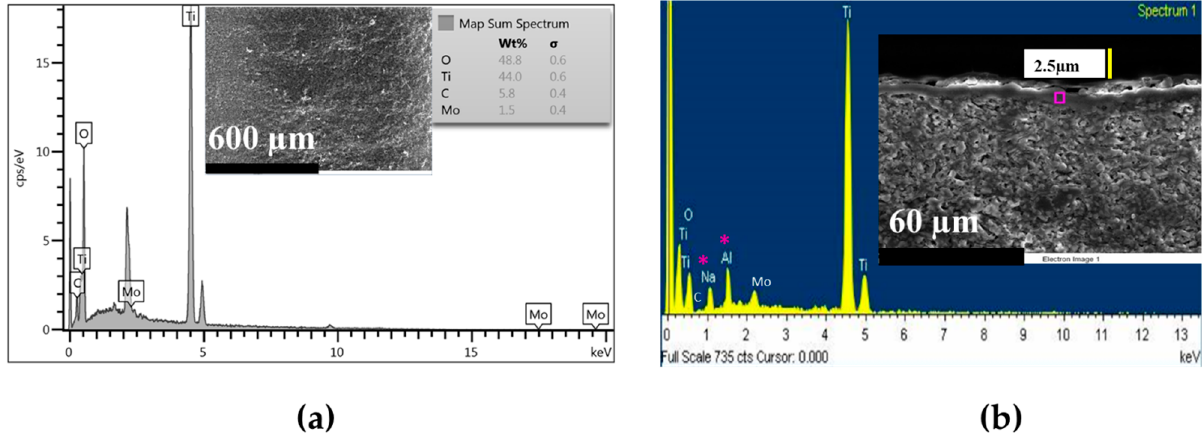
Figure 9. ( a ) SEM-EDS and ( b ) cross-sectional SEM-EDS of active modified Mo/HRTiO 2 topcoat on the α -Al 2 O 3 ceramic support.